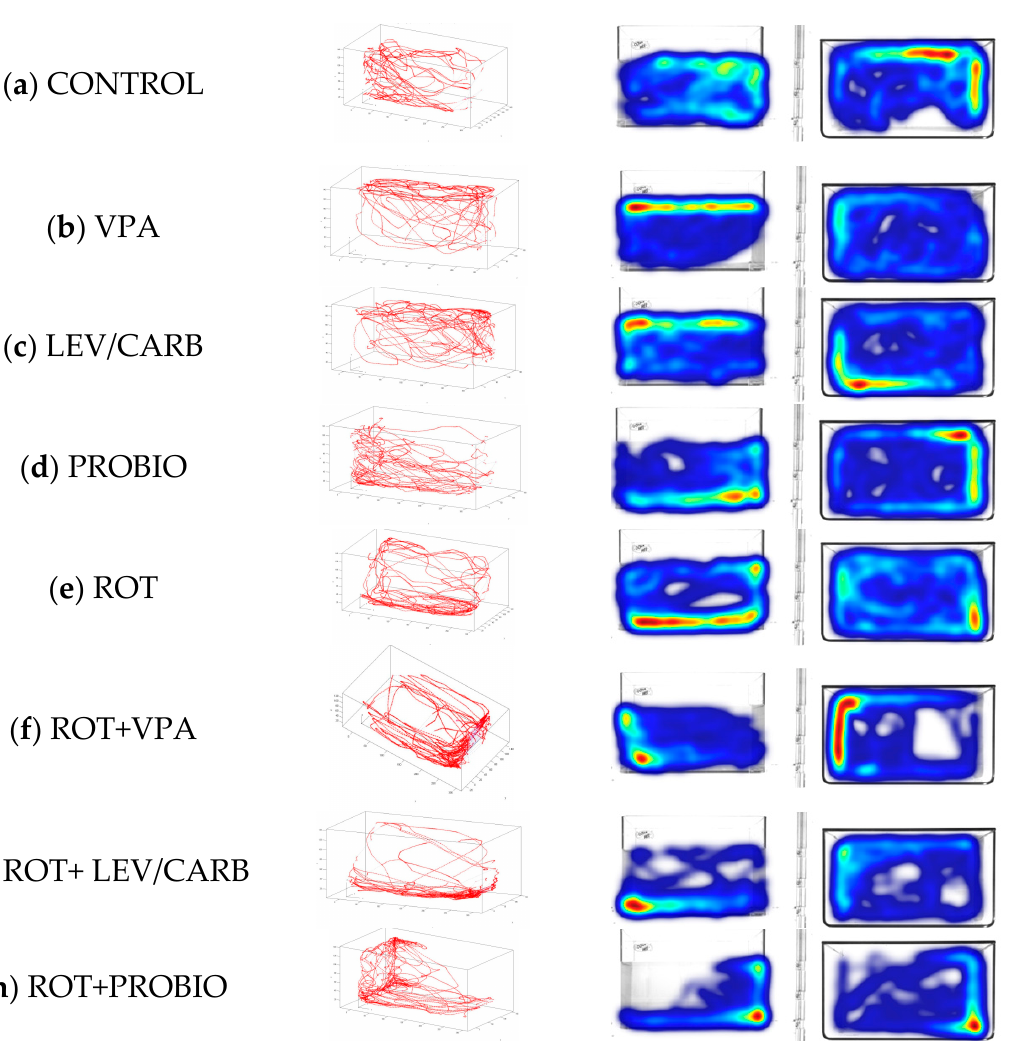
Figure 1. The 3D swim trace results for Danio rerio ( n = 5) in ( a ) CONTROL and the groups treated with ( b ) VPA—0.5 mg/mL, ( c ) LEV/CARB—250 mg + 25 mg, ( d ) PROBIO—3 g, ( e ) ROT—2.5 µg/L,